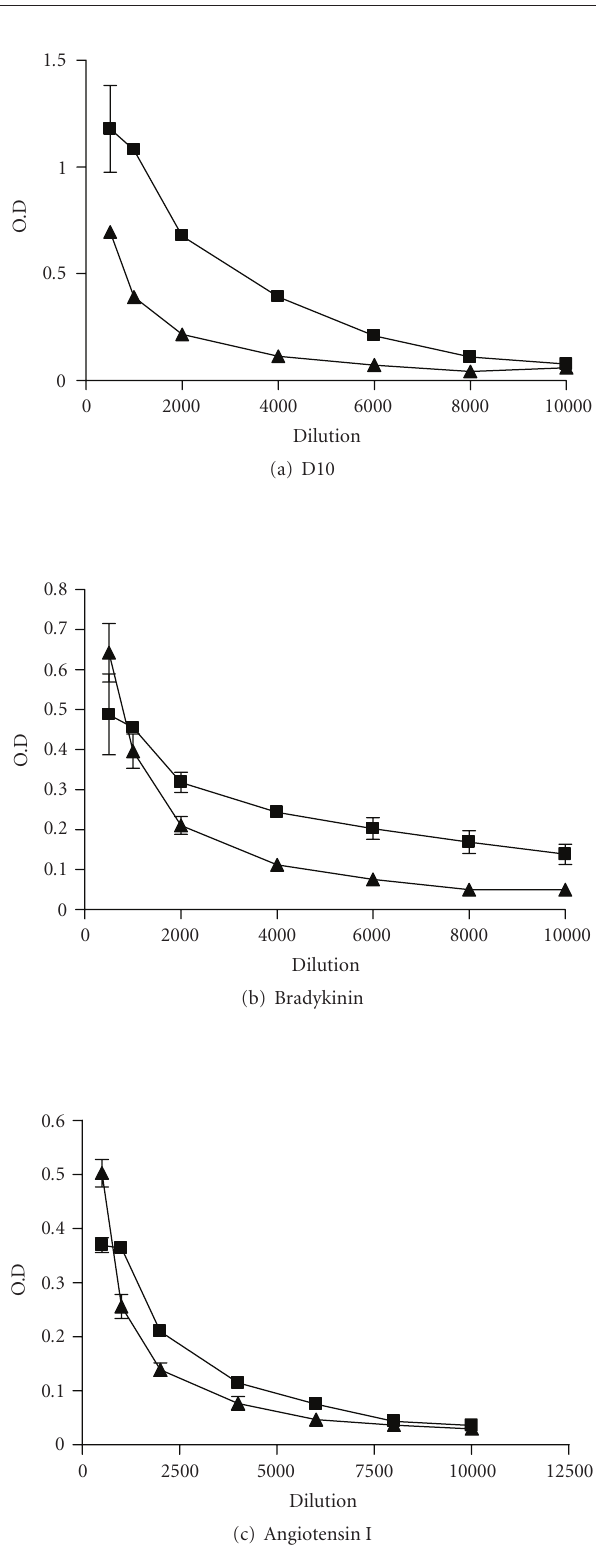
Figure 6: The crossreactivity of D10 antibody with bradykinin and Ang I. Hyperimmune sera from D10 immunized mice ( (cid:2) ) or nor- mal mice sera ( (cid:3) ) were diluted as indicated and reacted with D10-, bradykinin-, or Ang I-coated ELISA plates as indicated. Bound an- tibodies were detected as described in Section 2. Data represents the mean ± SD of